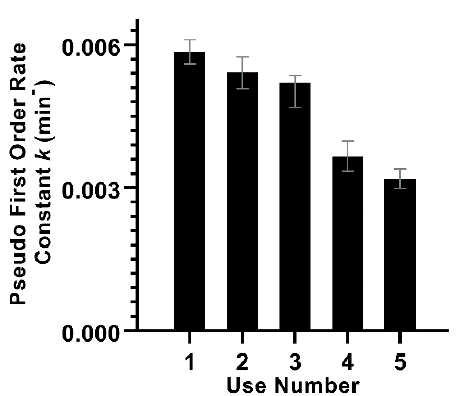
Figure 5. Reusability tests: pseudo first-order reaction rate constants for TMP experiments (i.e., the same coated disc was reused with 1 L of spiked water and 36 W UVA).